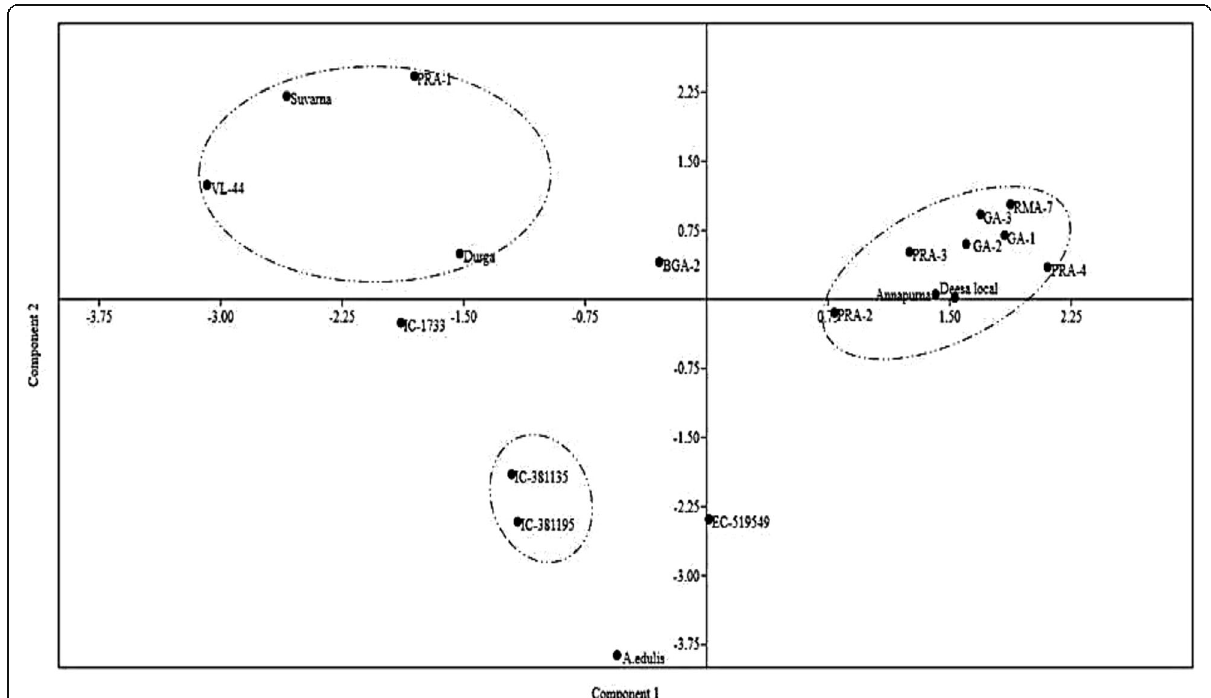
Fig. 3 Principle component analysis (PCA) of grain amaranth